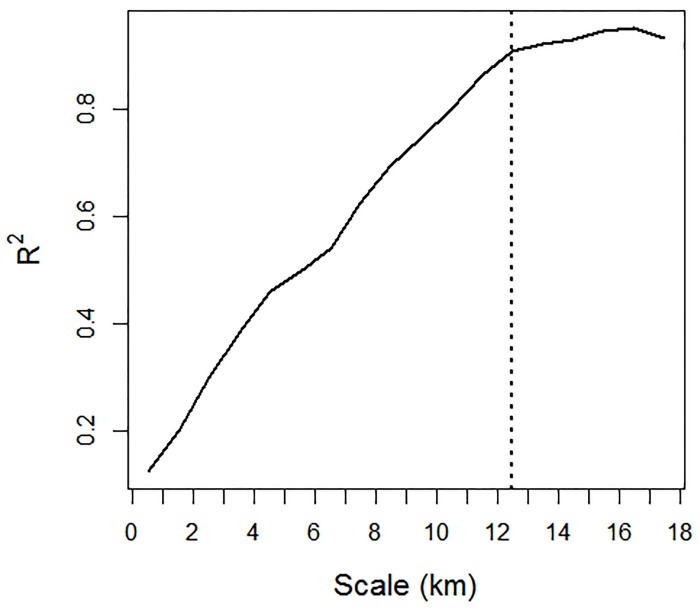
Coefficient of determination (R2) values of least squares regressions for 18 models comparing relative abundance estimates using the nautical area scattering coefficients (sA) (m2 nmi-2) between schools from the scientific echo-sounder (SES) and the recreational fish-finder (RFF) at different scales: 0.5 km–18 km, hatched vertical line denotes asymptote (12.5 km).